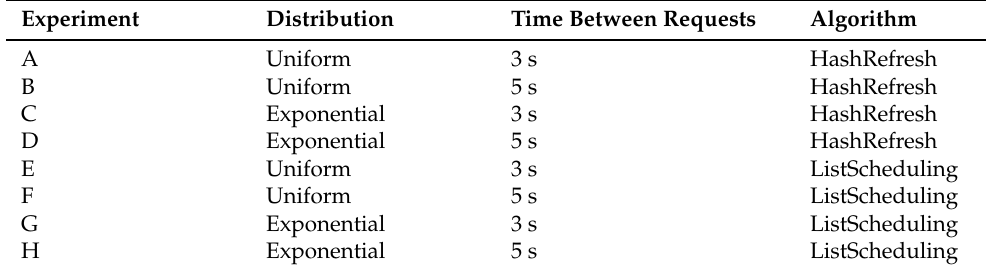
Table 4. Table of Experiments.